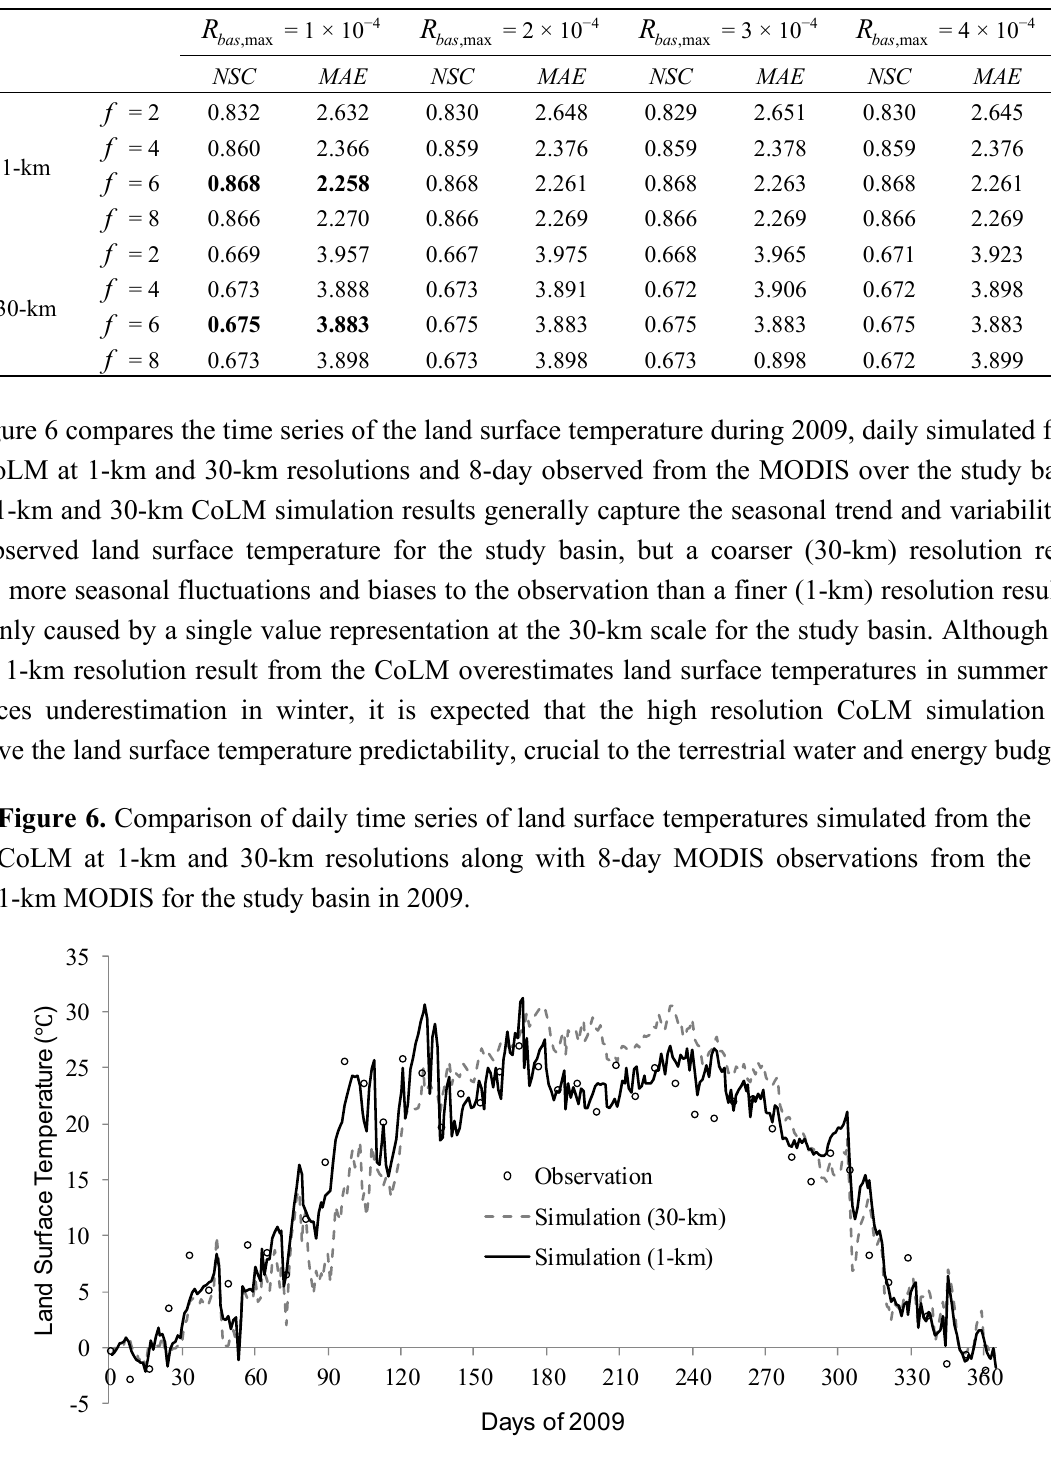
Table 3. Comparison of the CoLM performance at 1-km and 30-km resolutions for land surface temperatures by the Nash-Sutcliffe coefficient NSC and the mean absolute error MAE with the decay factor f (in·m − 1 ) and the maximum baseflow coefficient R (in mm/s) changes for the study basin in 2009.